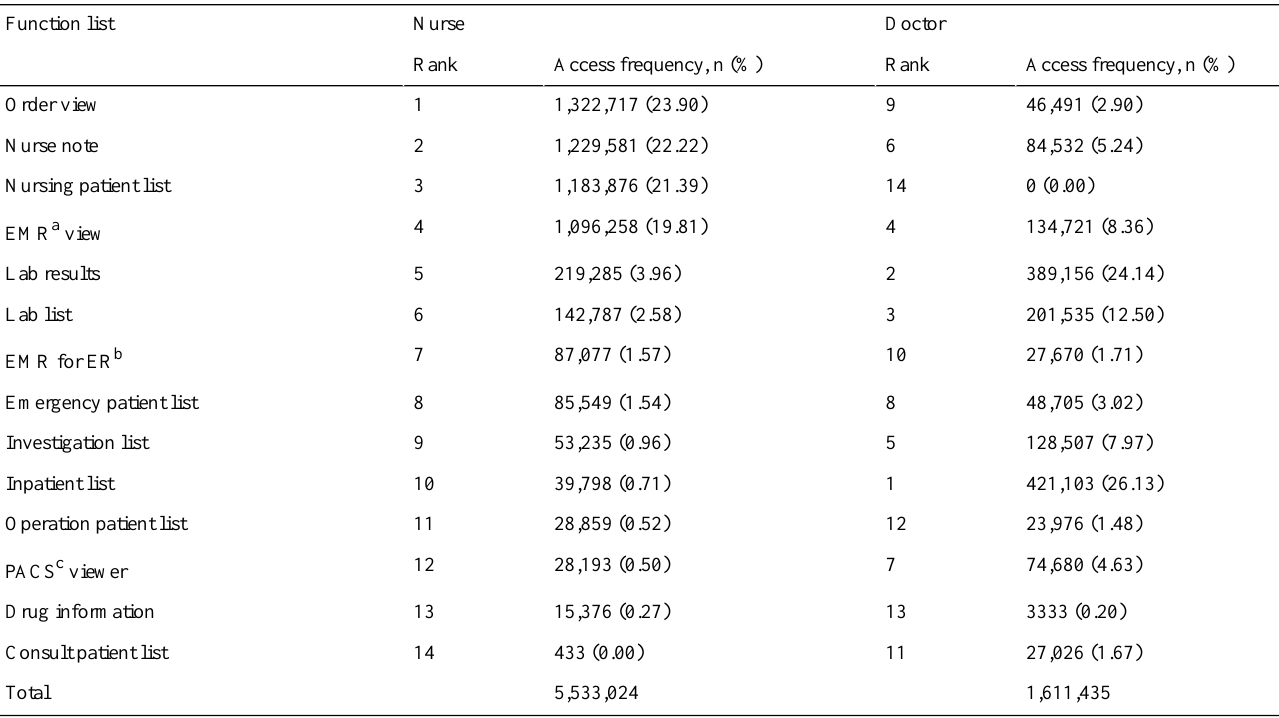
Table 2. Ranking of mobile Asan Medical Information System services based on user occupations. DoctorNurseFunction